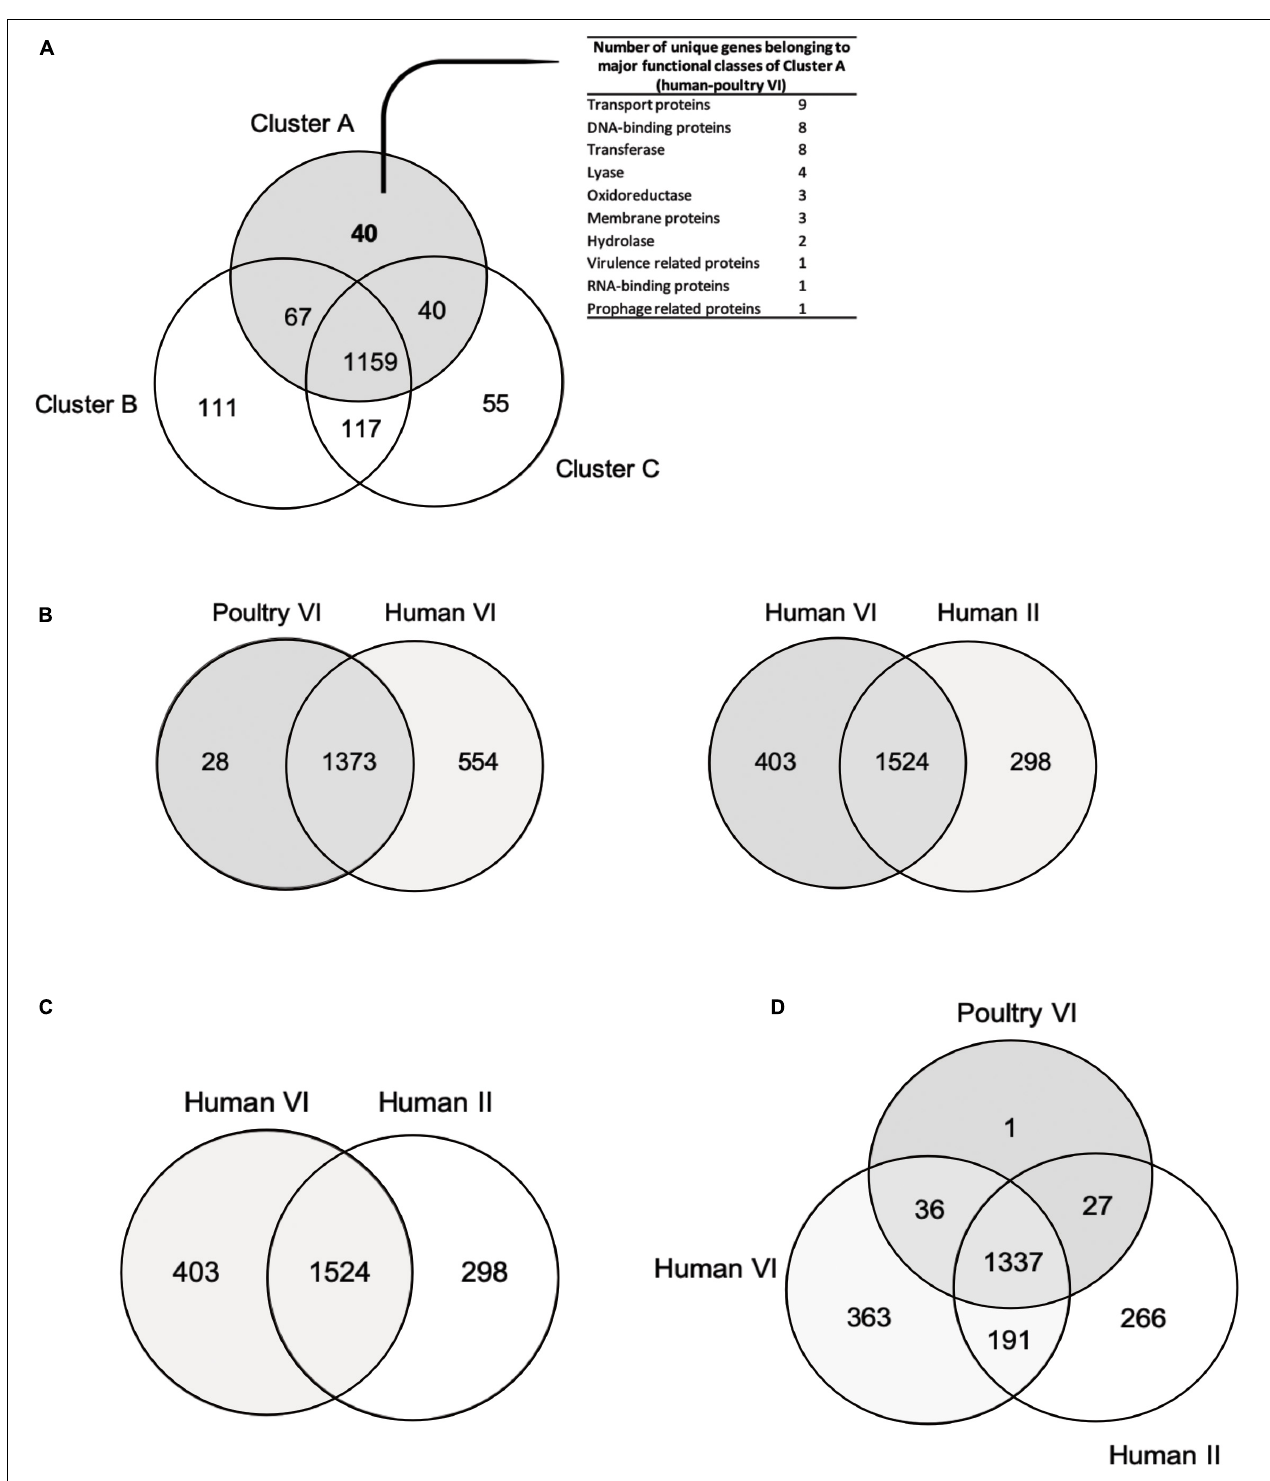
FIGURE 4 | Venn diagrams showing number of reciprocal best hits among different L. reuteri subset of core genomes. (A) Number of shared and unique genes of core genomes of cluster A (poultry/human lineage VI), cluster B (lineages human II, herbivore VII, porcine IV and rodent III) and cluster C (lineages rodent I, rodent III, herbivore VIII and porcine V). (B) Number of shared and unique genes of poultry VI genomes and human VI genomes. (C) Number of shared and unique genes between human VI and human II strains. (D) Number of shared and unique between poultry VI, human VI and human II lineages. Unique genes of human/poultry VI clades (A) and human VI isolates (B) are listed in Supplementary Table S3